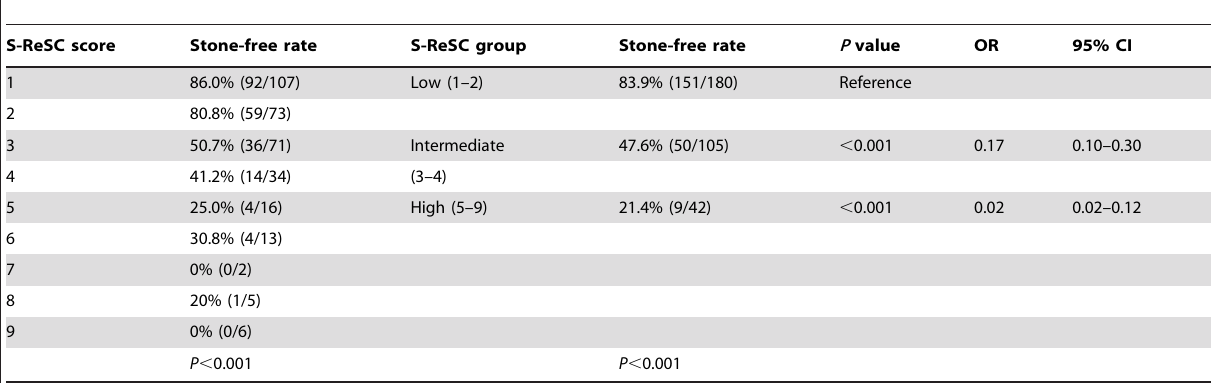
Table 2. Stone-free rates according to S-ReSC scoring